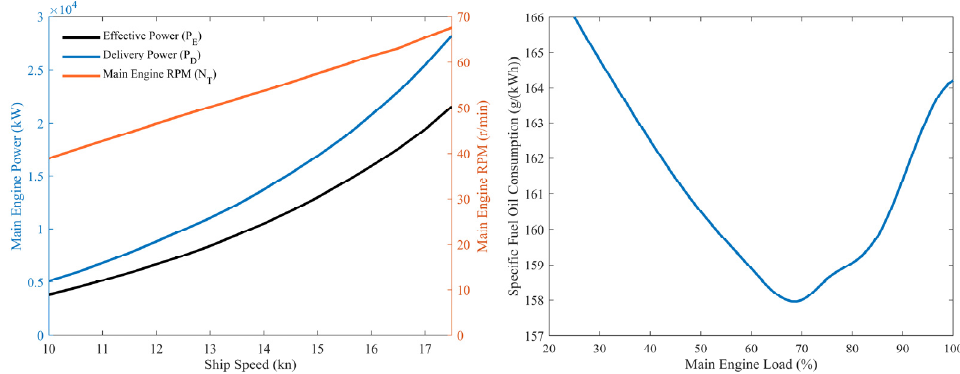
Figure 2. Ship’s speed/power trail performance (l eft ) and main engine’s SFOC curve ( right ).